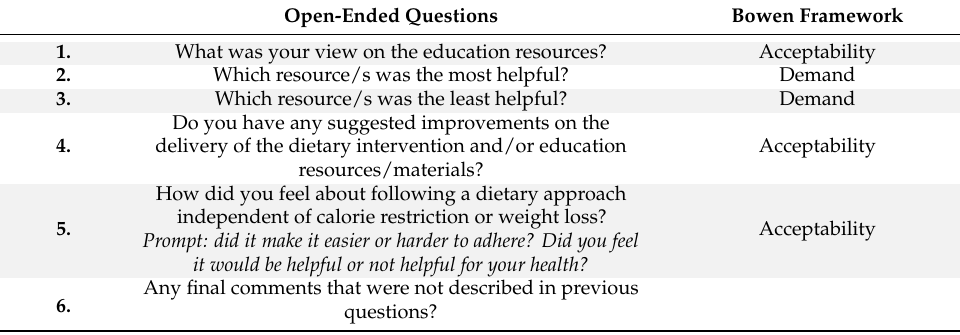
Table 6. Assessment of dietary intervention resources and deliver.